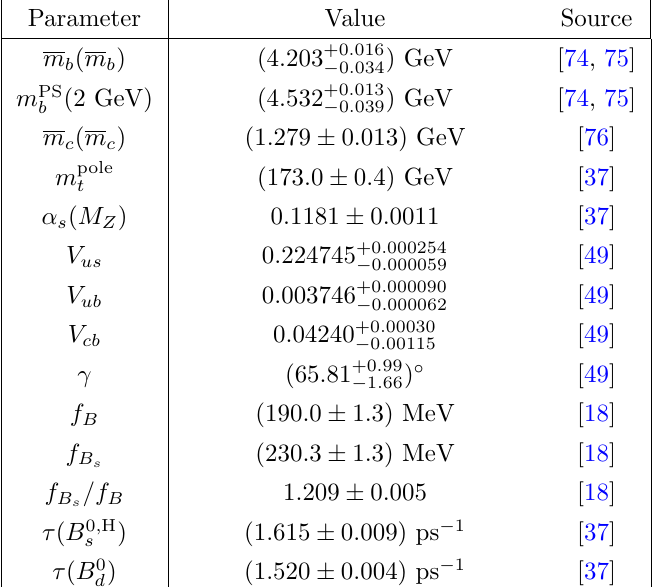
Table 1 . Input values for parameters.